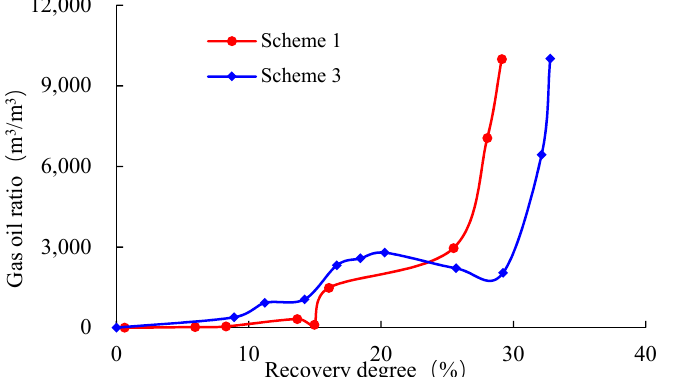
Figure 18. The relationship between recovery degree and gas oil ratio (Scheme 1 and Scheme 3).